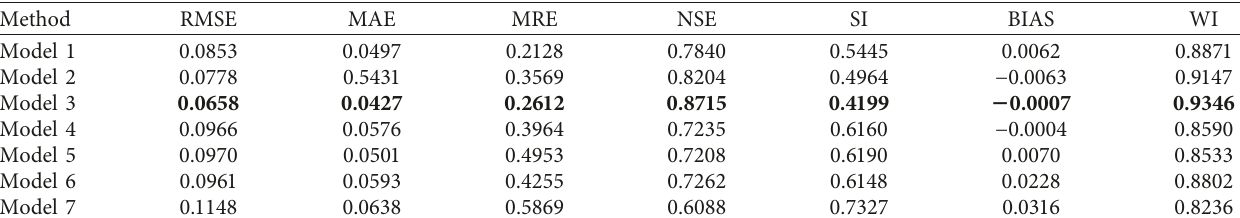
Table 10: The numerical evaluation indicators for the BF-SVR predictive model over the testing modeling phase.